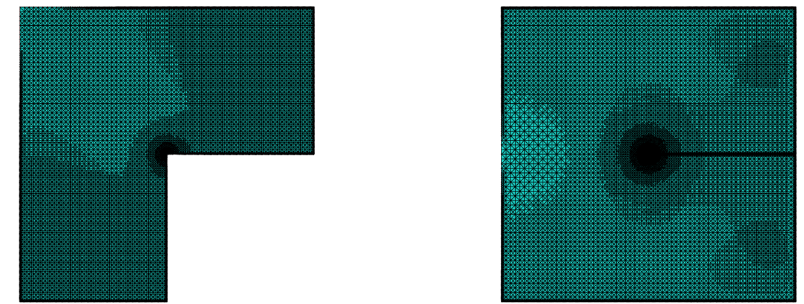
Figure 7: The adaptive meshes obtained by Algorithm 5.1 as i = 25, k = 1, and n ( x ) = 4 + 4 i